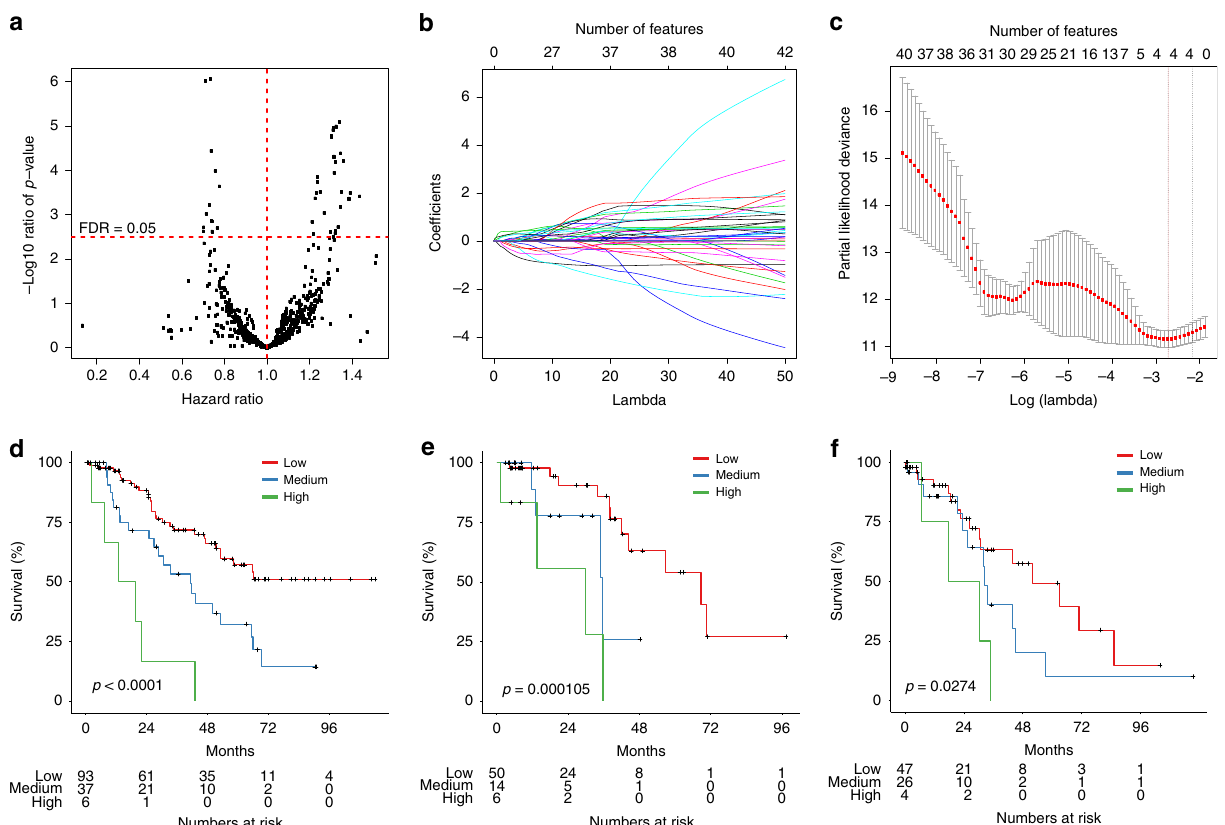
Fig. 2 Prognostic model based on radiomic pro fi le in HGSOC. a Summary of univariate Cox regression between each radiomic feature and overall survival in the discovery set. Each black point represents the p value ( y -axis) and hazard ratio (HR; x -axis) of a radiomic feature. Red horizontal dashed line indicates the false discovery rate (FDR) of 0.05; red vertical dashed line indicates HR of 1. b Least absolute shrinkage and selection operator (LASSO) regression analysis was performed to select radiomic features for prognostic model-building for HGSOC patients. Feature coef fi cients were plotted against shrinkage parameter (Lambda). c Partial likelihood deviance from Cox regression ( y -axis) was generated under different shrinkage parameters ( x -axis). Number of features selected corresponding to each lambda are given above the plot. Kaplan − Meier analyses were performed between radiomic prognostic vector (RPV) and overall survival in d HH discovery cohort ( n = 136), e TCGA validation cohort ( n = 70) and f HH validation cohort ( n = 77). Red line, RPV low; green line, RPV medium; blue line, RPV high. p values are given by log-rank test. HGSOC high-grade serous ovarian cancer, TCGA the Cancer